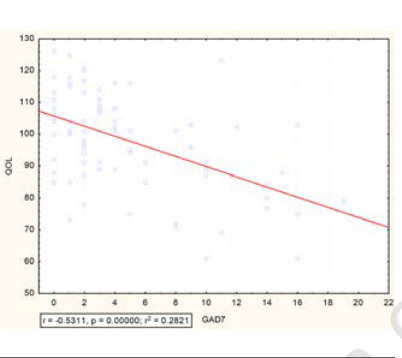
Figure 2. Correlation between Generalized Anxiety Disorder seven-item and the health-related quality of life rates.